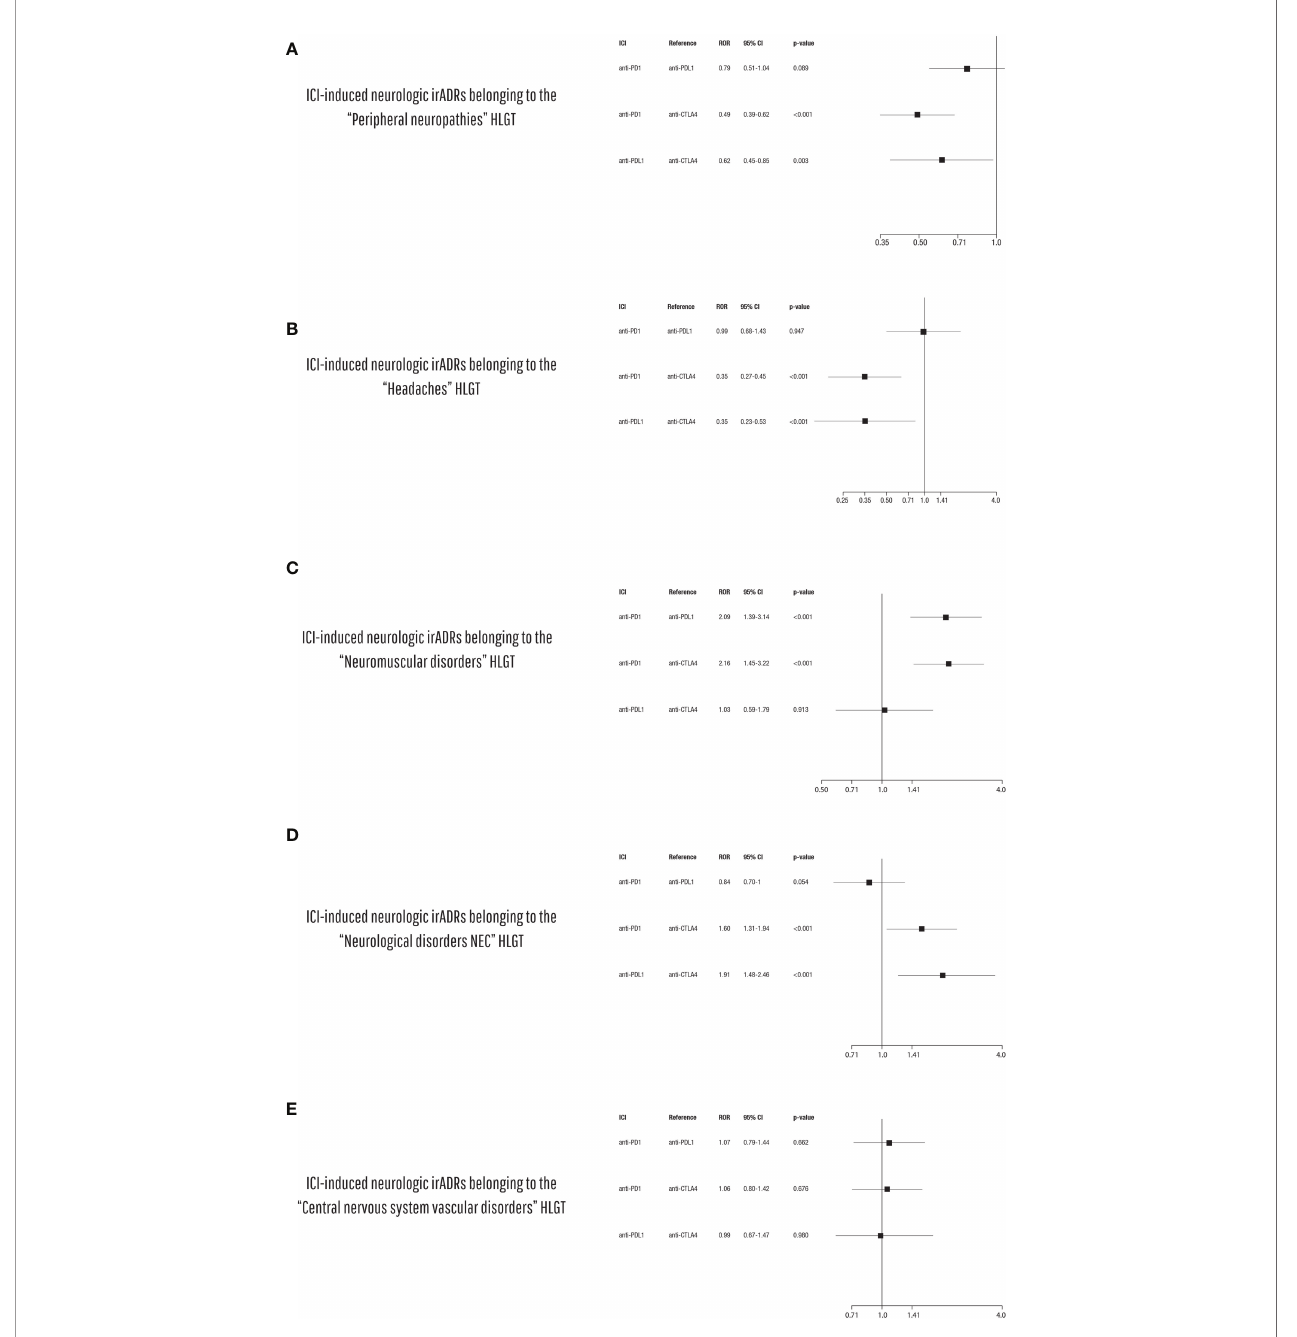
FIGURE 6 | Disproportionality analysis of ICI-induced neurologic irADRs belonging to (A) the “ Peripheral neuropathies ” , (B) the “ Headaches ” , (C) the “ Neuromuscular disorders ” , (D) “ Neurological disorders NEC ” , and (E) “ Central nervous system vascular disorders ” HLGTs comparing the different ICI classes to each other (anti-PD-1 vs. anti-PD-L1 vs.